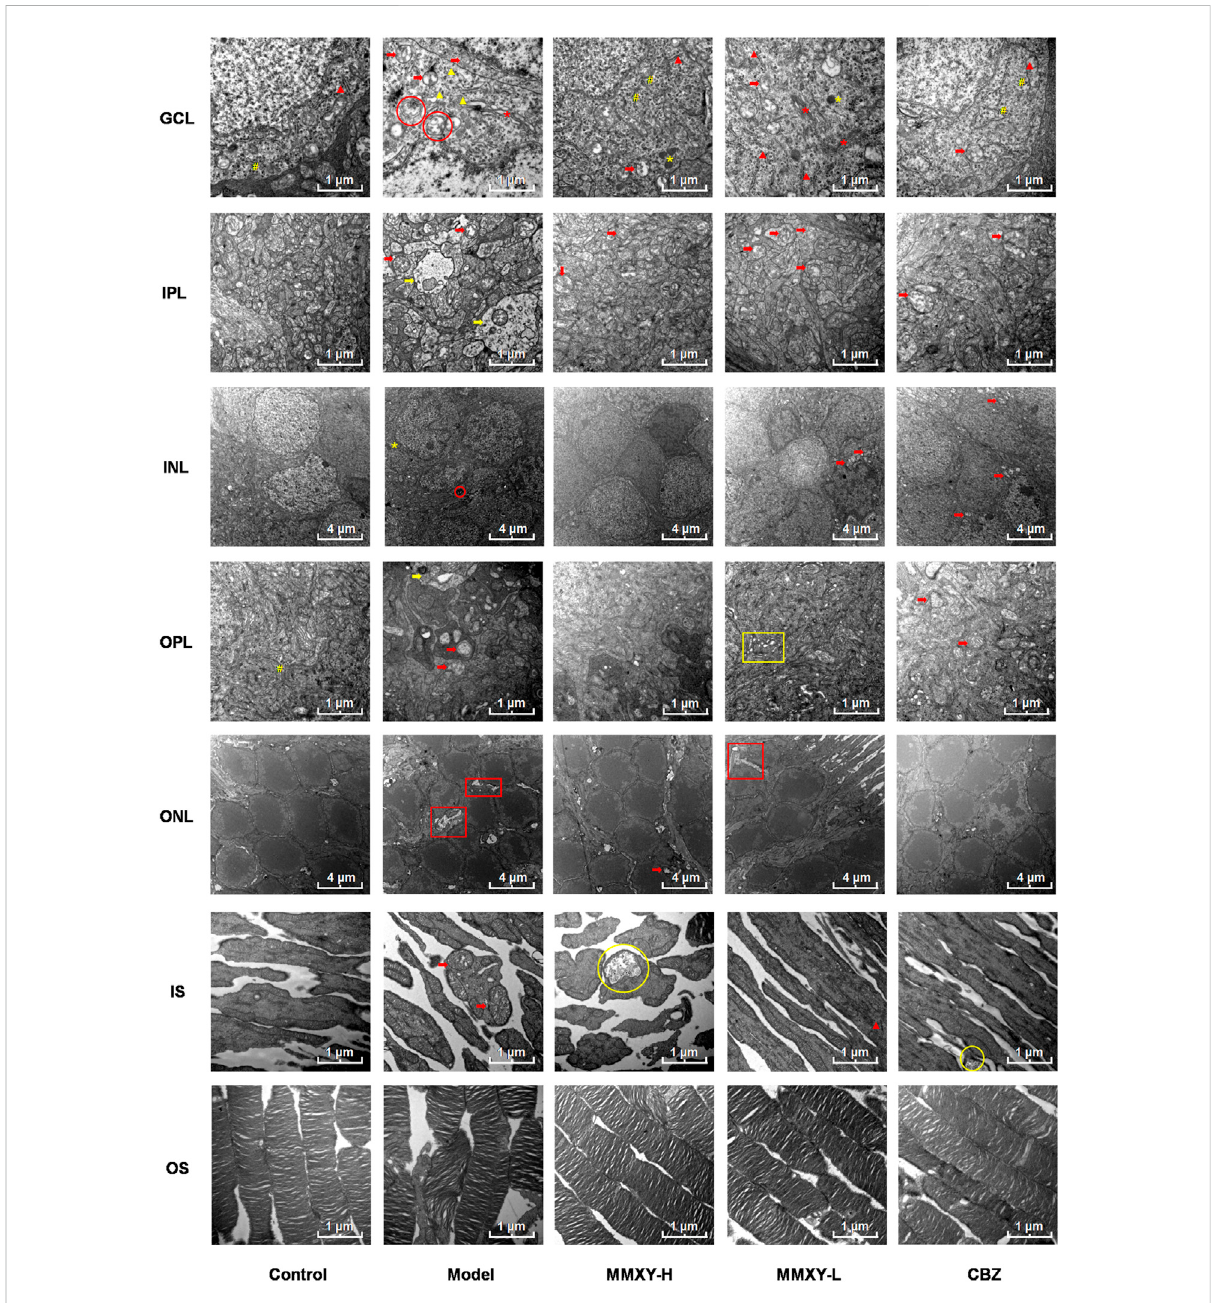
FIGURE 9 Electron microscope ultrastructure of rat retina. The ultrastructure of retina in model group was severely damaged. In the model group, the photoreceptorsshowedanincreaseinthespacesbetweentheirOSsandthosebetweentheirmembranousdisks;Swollenmitochondrias(redarrow) and autophagosomes (red circle) were seen in GCL, and swollen synapses (yellow arrow) were seen in IPL and OPL. In MMXY-H group, the photoreceptors showed marked reduction in the spaces between their OSs and those between their membranous disks compared to model group, mitochondrial swelling wasrarein GCL,and there wasno obvioussynaptic swelling in IPL and OPL. Red arrow, swollen mitochondria; Yellow arrow,Swollenneuronsynapse;Redcircle,autophagosomes;Yellowcircle,glycogengranules;Redasterisk,Golgi;Yellowasterisk,lysosome;Yellow well,Polyribosome;Redtriangle,roughendoplasmicreticulum;Yellowtriangle,smoothendoplasmicreticulum;Yellowbox,endoplasmicreticulum swelling; Red box, interstitial